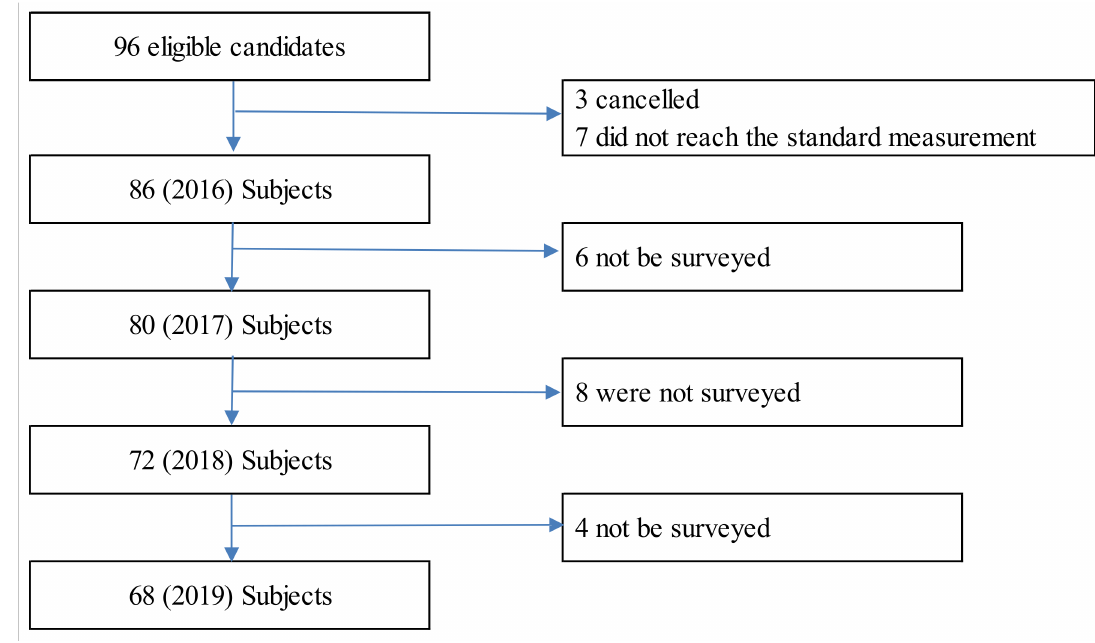
Figure 1. Follow-up